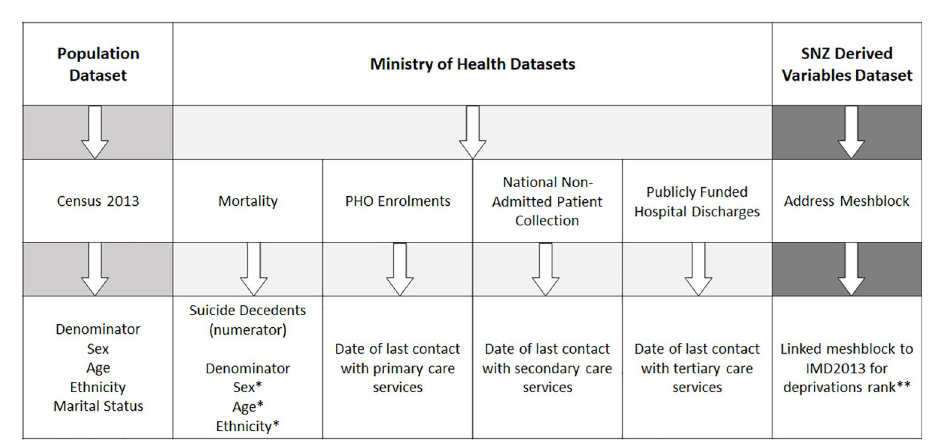
Fig 1. Flow diagram of the source dataset in the IDI (Top row), the specific data tables utilised (Middle Row) and the variables that were extracted for our analyses (Bottom Row). � Where data was not available in the Census dataset, this was supplemented from data in the mortality dataset. �� Where address data was not available from either Census or mortality datasets, this was imputed from the SNZ derived variables dataset.